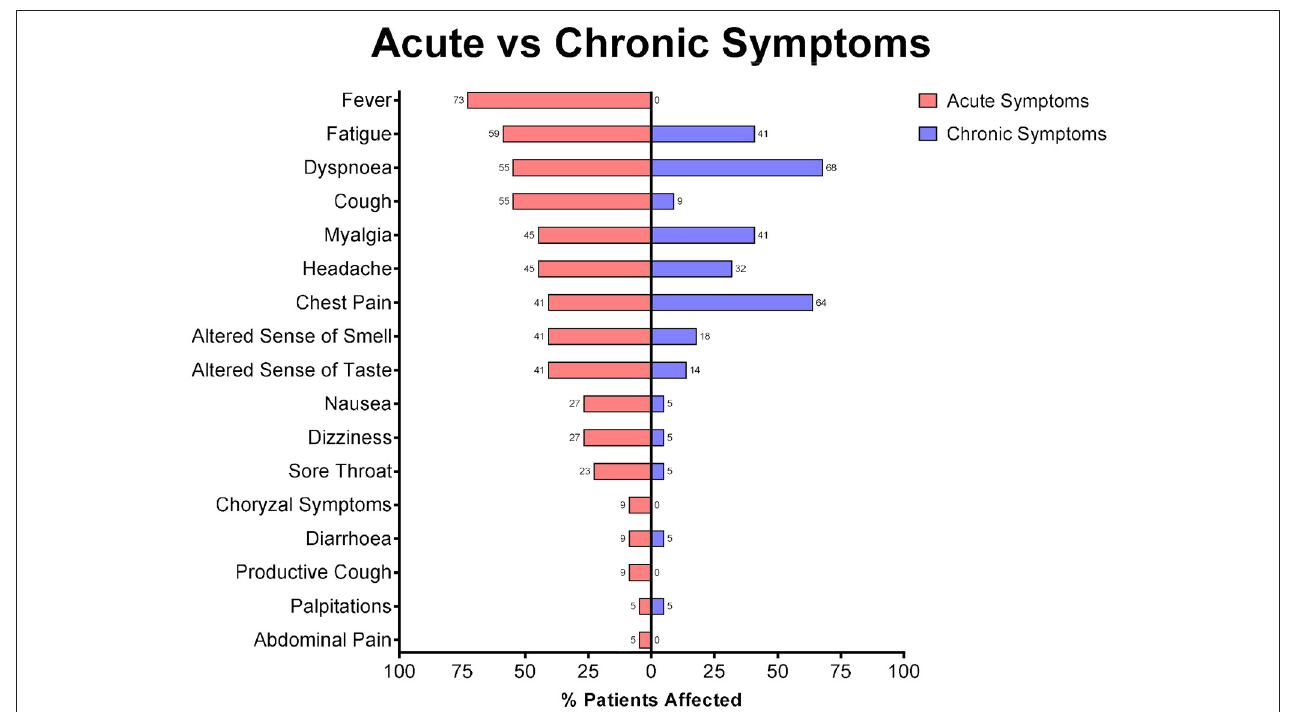
FIGURE 1 | Reported symptoms of patients during the acute illness and on review in the cardiology clinic.